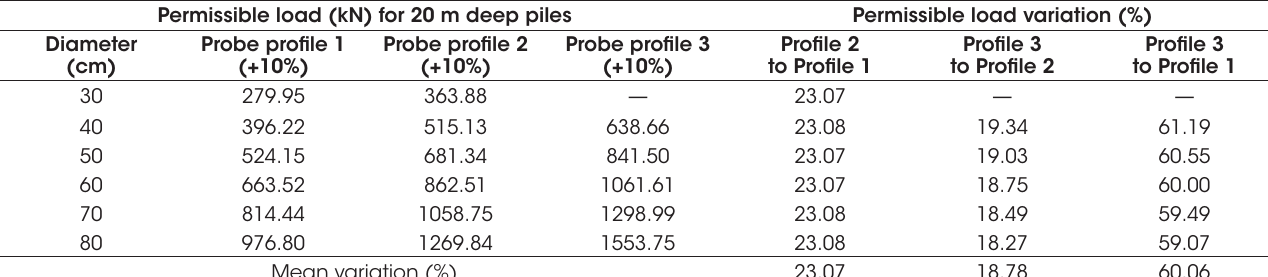
Load capacity according to the Aoki and Velloso method [25] for depths of 20 m Permissible load (kN) for 20 m deep piles